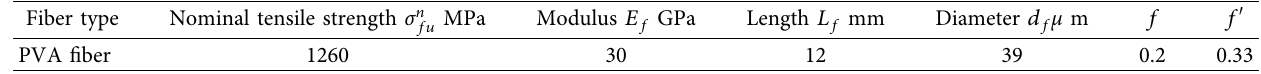
Figure 14: Fiber bridging stress versus crack opening relation. Table 2: Physical properties of the PVA fibers